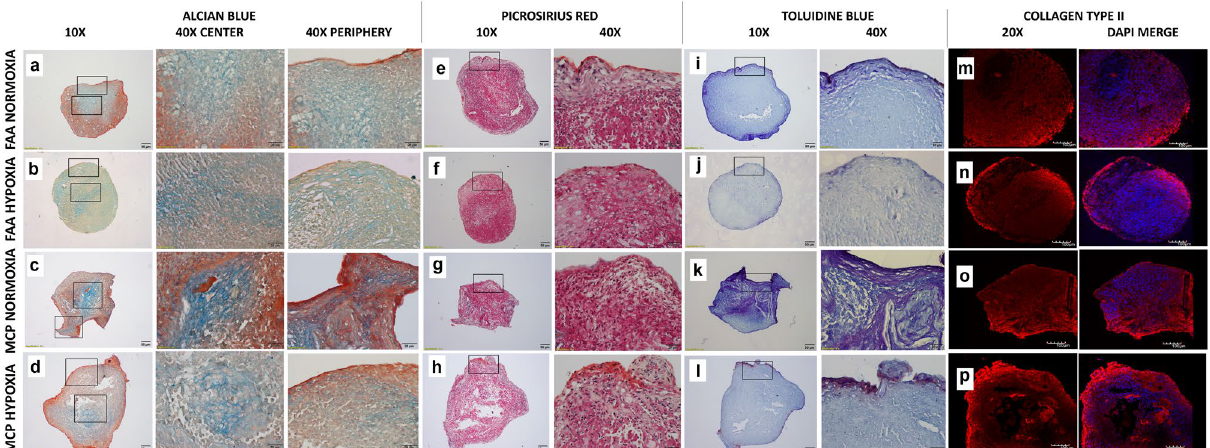
Figure 6. Representative image of the three independent experiments. Histological staining of chondrogenic differentiated chondroprogenitor pellets under normoxic and hypoxic culture conditions: FAA-CP-Normoxia, FAA-CP-Hypoxia, MCP-Normoxia, MCP-Hypoxia. The formed pellets (5 × 10 5 ) were grown in StemPro chondrogenic medium for a period of 3 weeks. Greater uptake of Alcian Blue ( a – d ) and Toluidine blue ( i – l ) was observed with the MCP-Normoxia pellets. All groups displayed comparable Picrosirius red uptake ( e – h ). Immunofluorescence imaging of the pellets for collagen type II ( m - p ) showed similar intensity with all groups. Magnification: scale bar (50 µm or 20